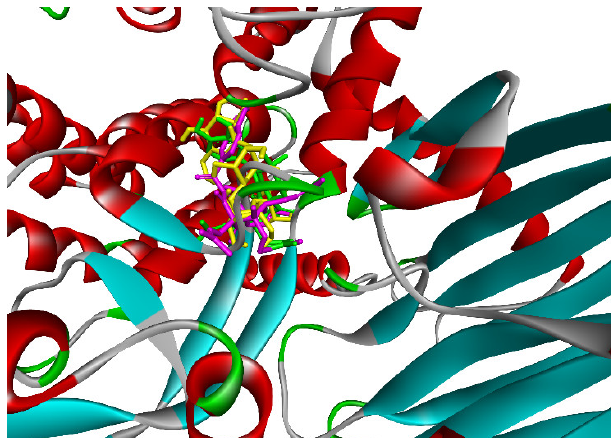
Figure 13. A ligand map exposing the secondary interactions such as hydrogen bonding and steric and overlap interactions between residual amino acids on enzyme 4J5T and pose 170/200, acarbose.